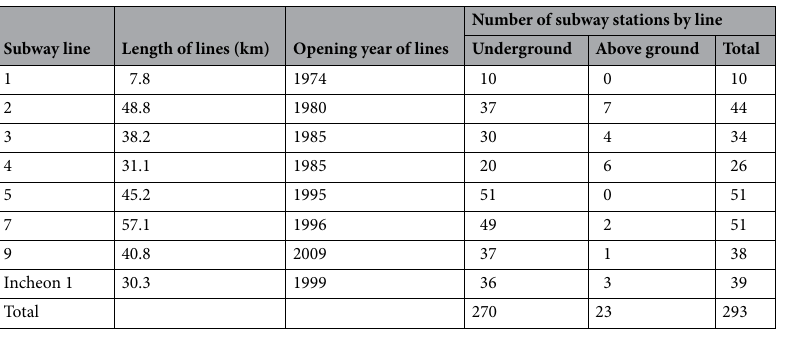
Table 1. General information on the subway line system in major metropolitan cities Seoul and